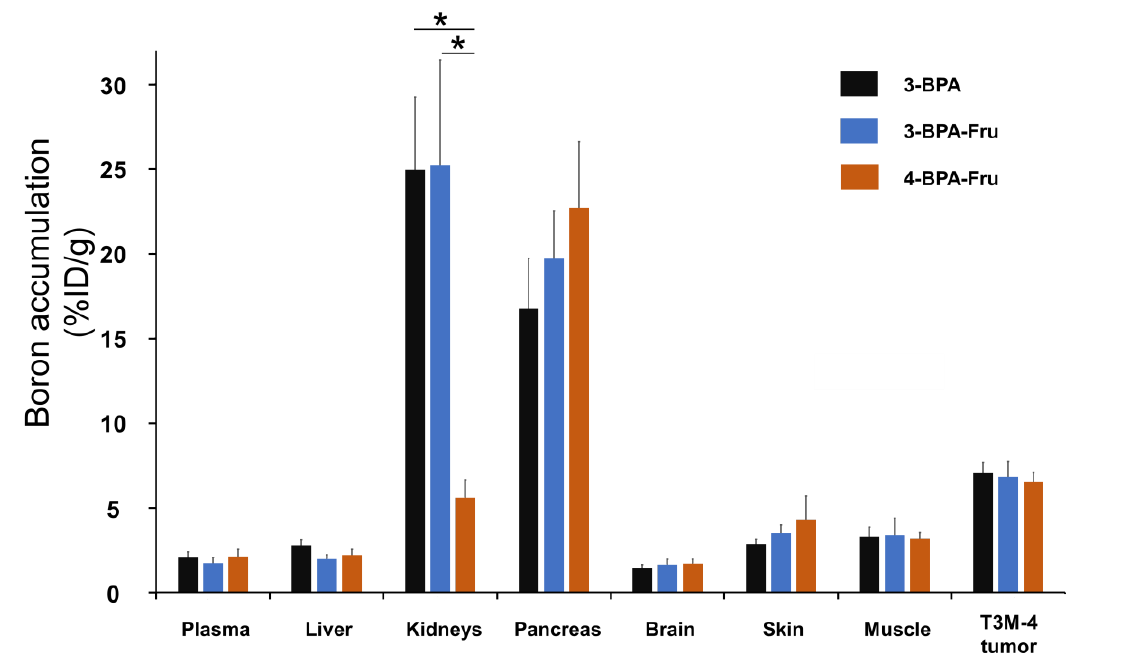
Figure 4. Boron accumulation in T3M-4 tumor, plasma, liver, kidneys, and the tissues surrounding the tumor at 60 min after administration of 3-BPA, 3-BPA-Fru, and 4-BPA-Fru into BALB/c nu-nu mice. * p < 0.001 by Tukey’s multiple comparison tests.